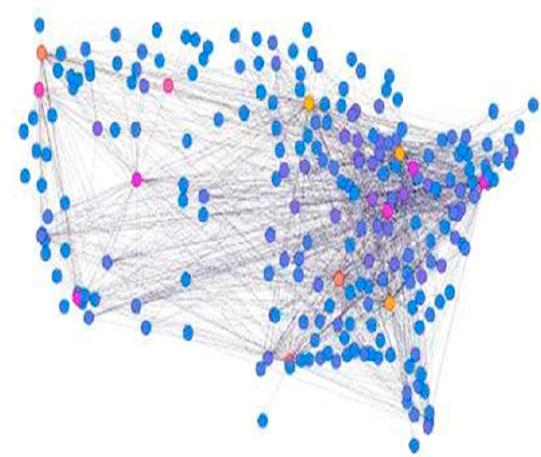
Figure 3. The layout of the 100 nodes .